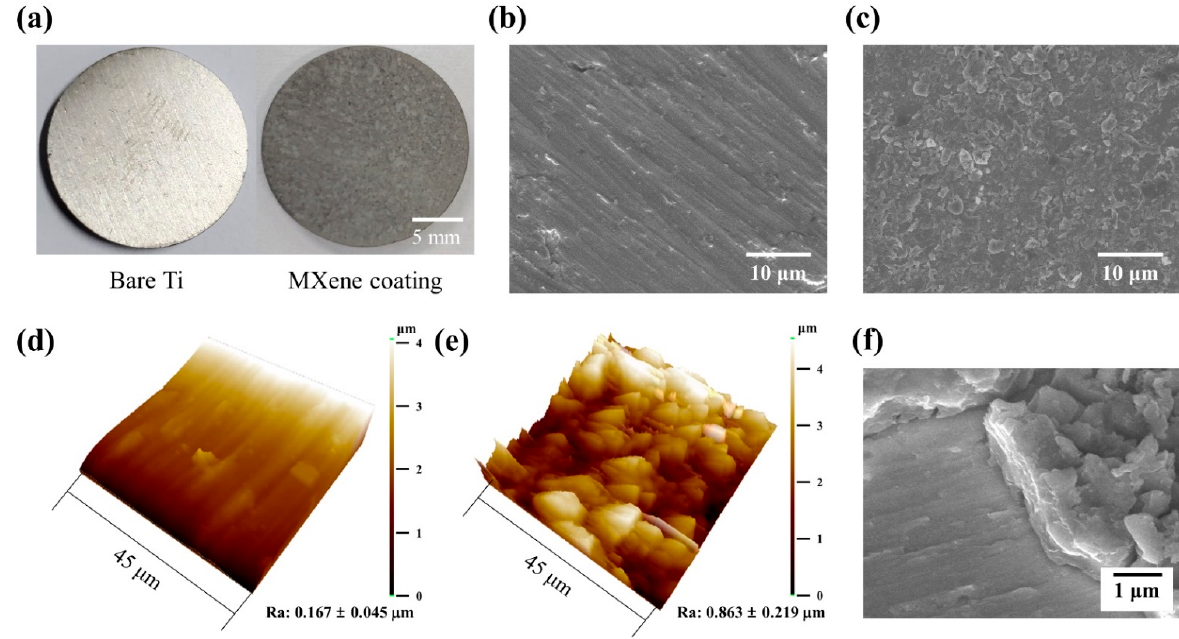
Figure 1. ( a ) Digital optical images of the bare and Ti 3 C 2 -coated Ti substrate. The microstructure observed using ( b , c ) field emission scanning electron microscopy (FE-SEM) and ( d , e ) atomic force microscopy (b and d; bare Ti, c and e; Ti 3 C 2 -coated Ti). ( f ) A FE-SEM image showing the cross-section of Ti 3 C 2 coating layer.